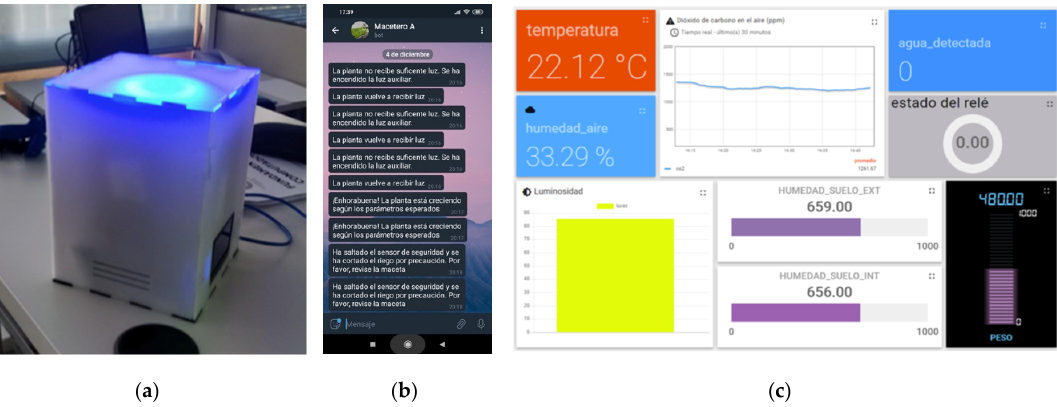
Figure 3. Feedback services configured: ( a ) Prisma, a visual feedback display; ( b ) Telegram messenger to receive alerts; ( c ) IoT cloud platform. Thingsboard.io desktop